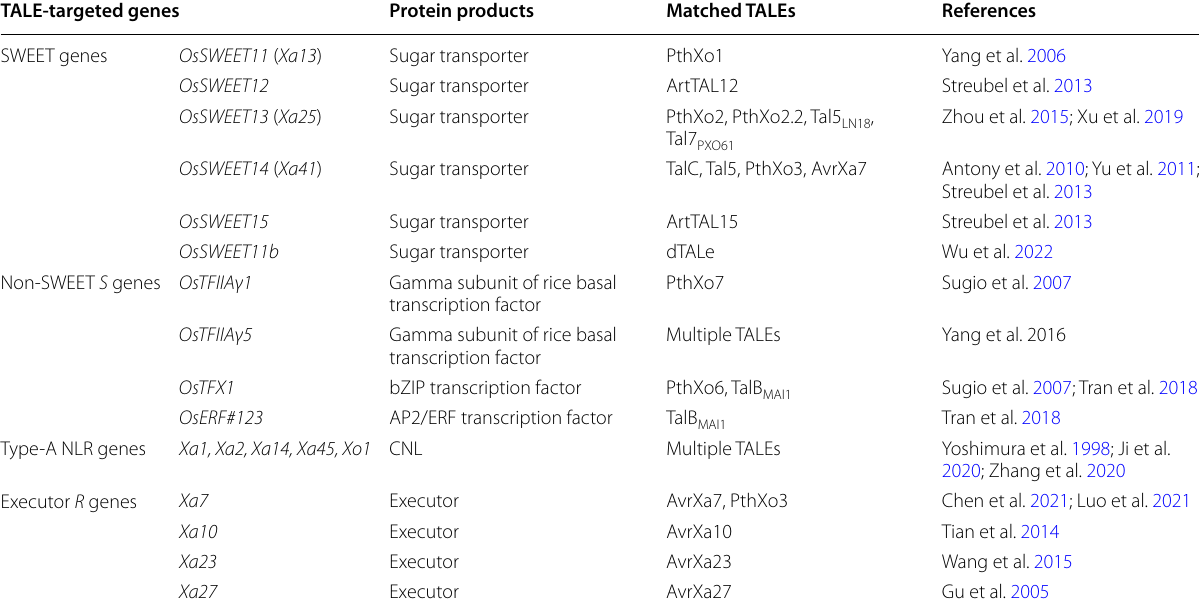
Table 2 Rice genes targeted by